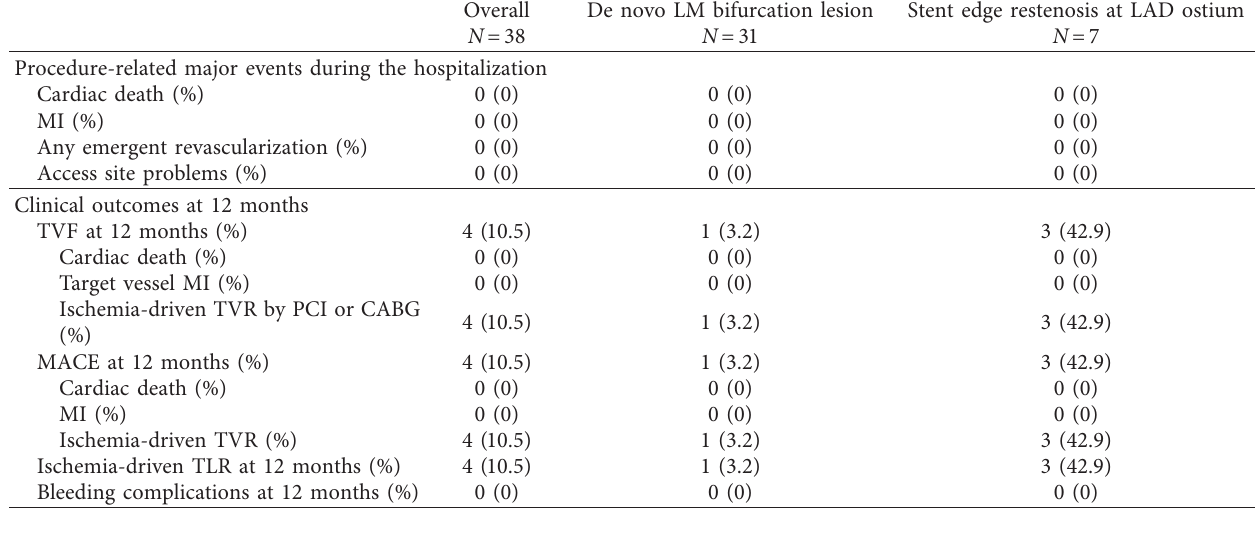
Table 5: Clinical